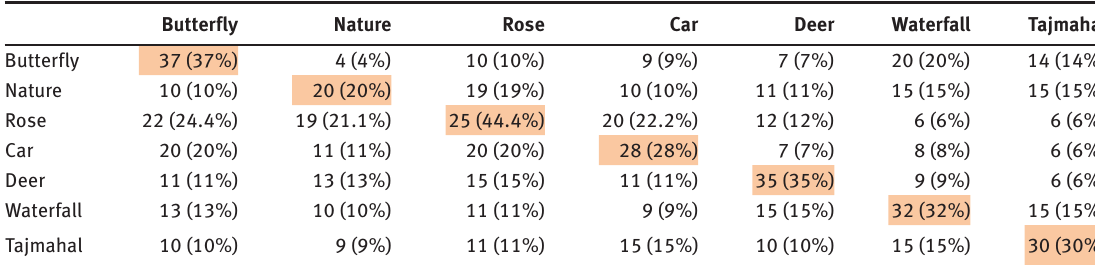
Table 5: Comparative Analysis Based on Average Precision Measure. Butterfly Nature Rose Car Deer Waterfall Tajmahal Theorem 1